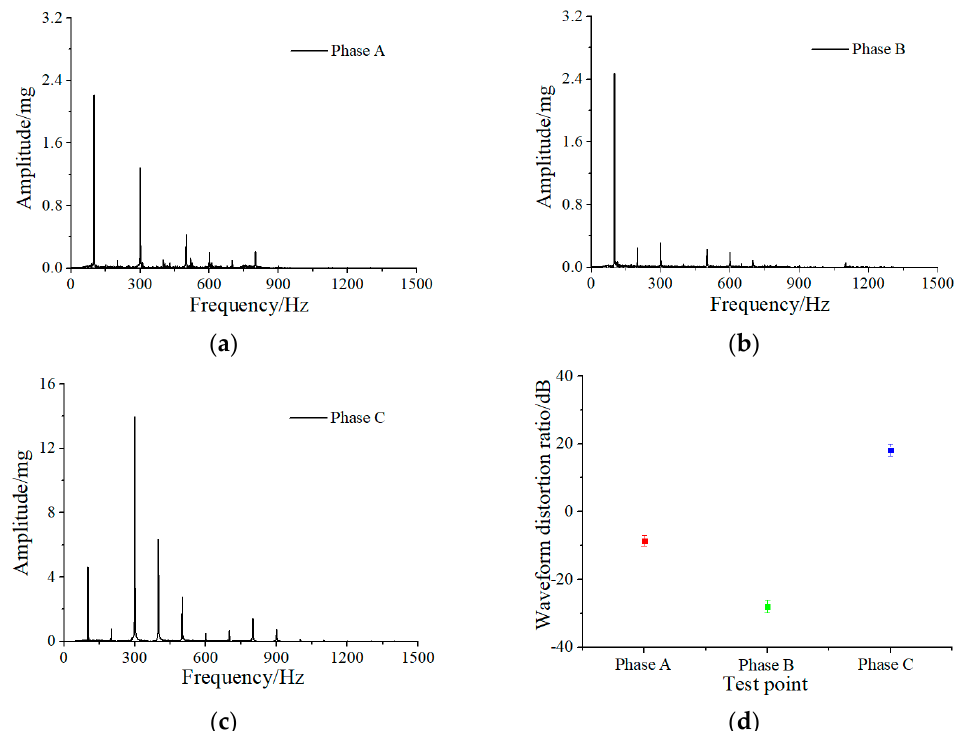
Figure 19. Frequency domain waveform of isolation switch. ( a ) Phase A; ( b ) Phase B; ( c ) Phase C; ( d ) comparison of all three phases.